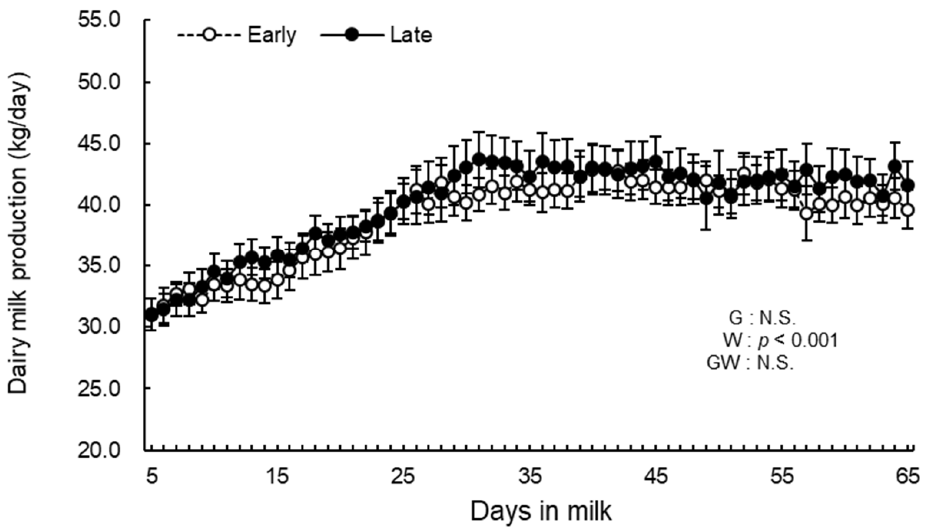
Figure 3. Daily milk production from 5 to 65 d postpartum for cows classified into the early group (Early) and late group (Late). Early = cows with endometrial inflammation converged within 4 wk (the week of calving is defined as 0 wk), n = 17; Late = cows with endometrial inflammation converged at or after 5 wk, n = 16. G = group effect; W = week effect; GW = group-by-week interaction. Data are shown as mean ± SEM.